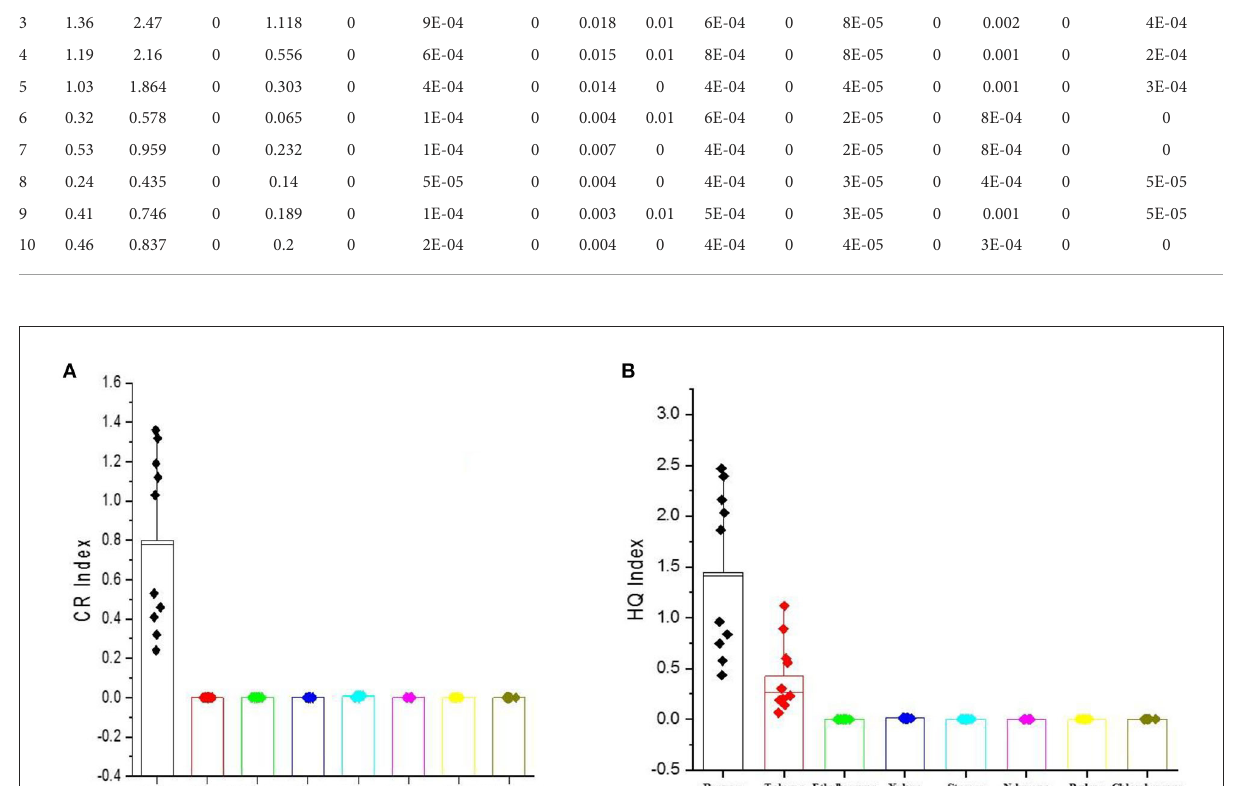
FIGURE4 (A) The evaluated results for cancer risk (CR) levels. (B) The evaluated results for non-cancer.